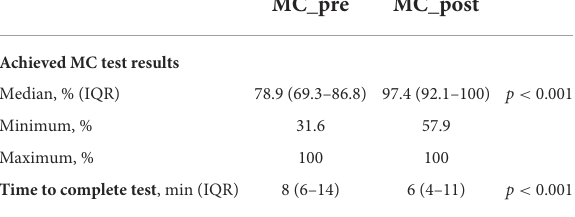
TABLE 1 Participants’ age, gender, previous knowledge, and timepoint of last resuscitation training.